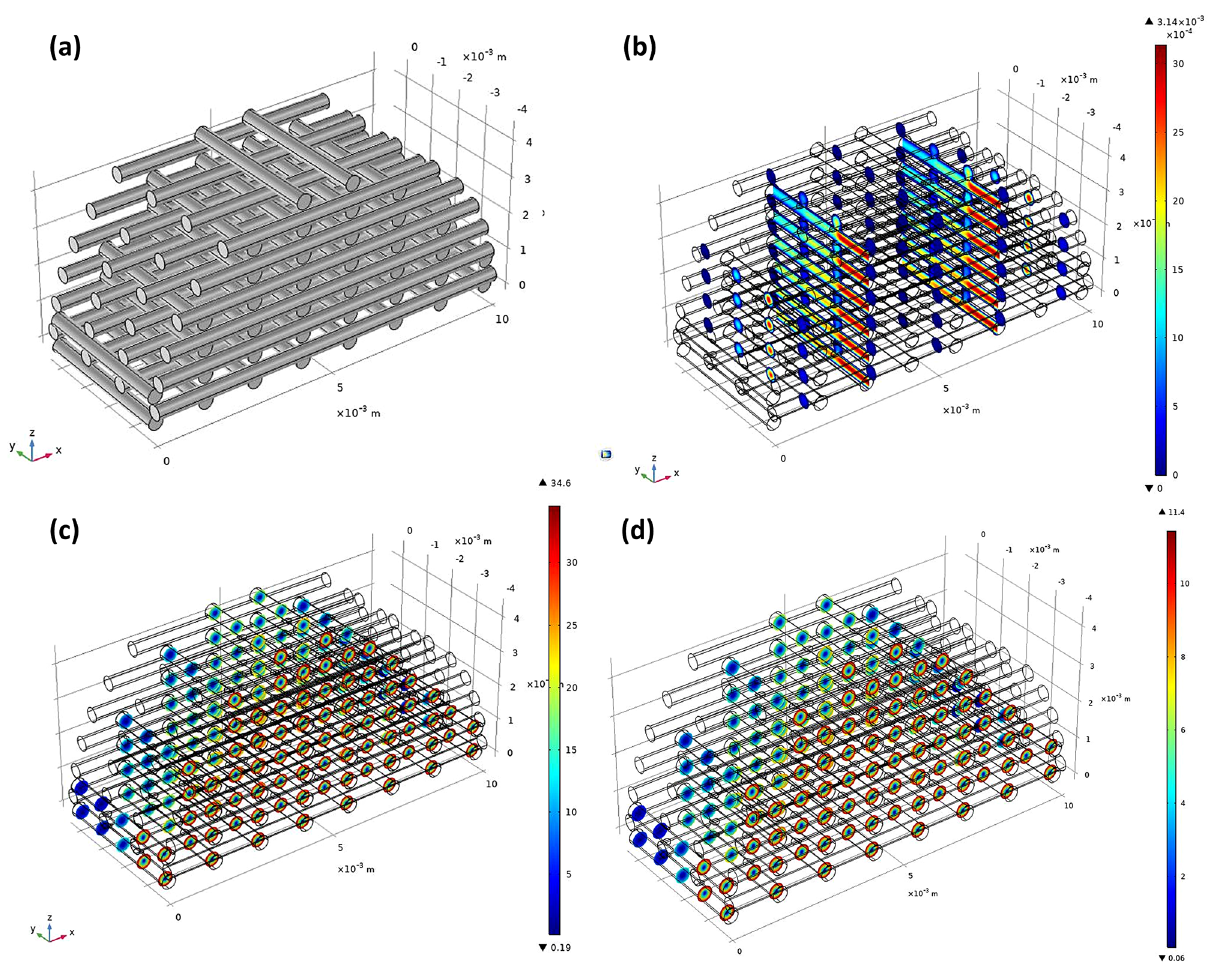
Fig. 7 a The 3D model of the half-scaffold used for the simula- tion of fluid flow inside the perfusion bioreactor, b the veloc- ity magnitudes throughout the 3D model for a volumetric flow rate of 8.0 × 10 –9 m 3 /s at the inlet to each cylinder, c the